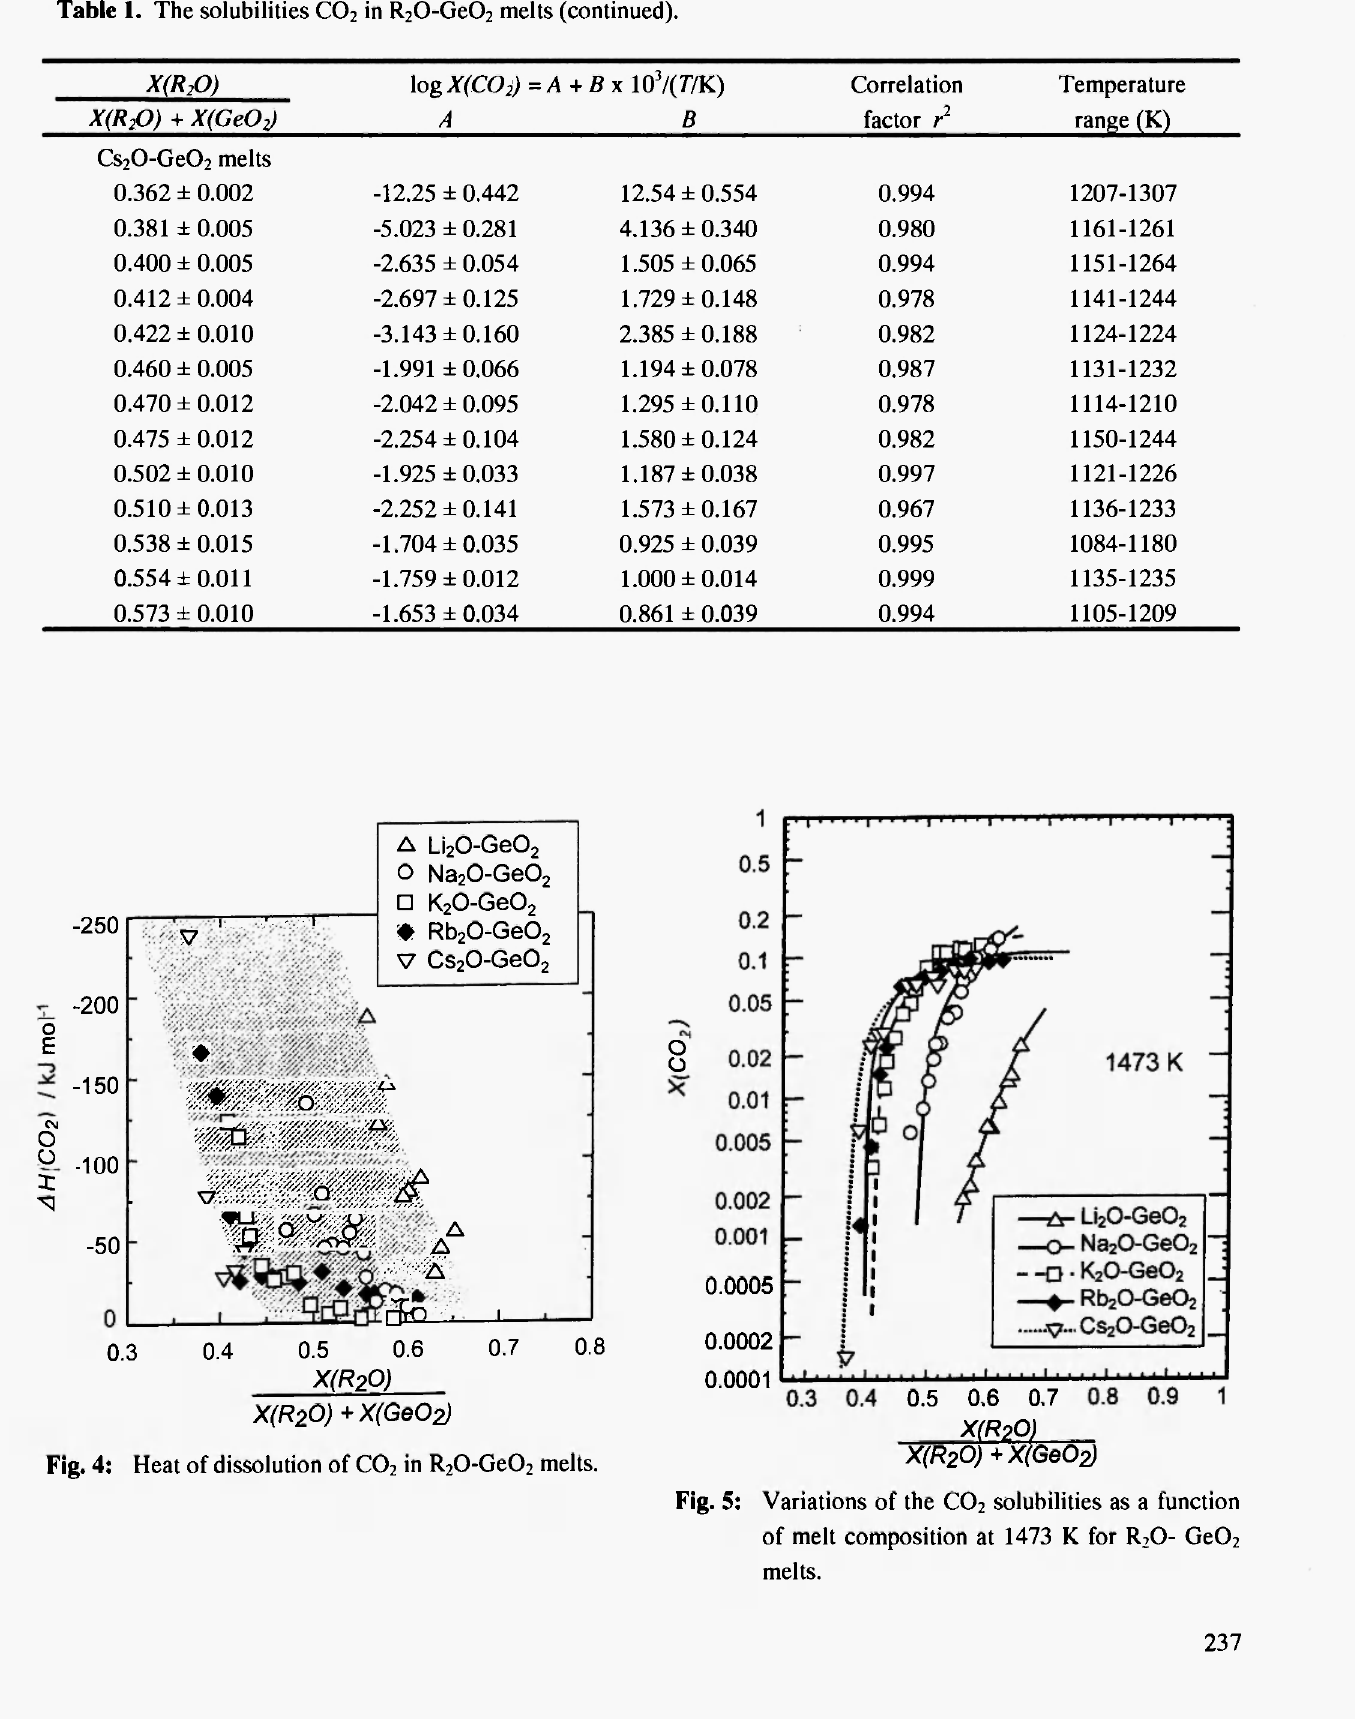
Table 1. The solubilities C0 2 in R 2 0-Ge0 2 melts (continued).